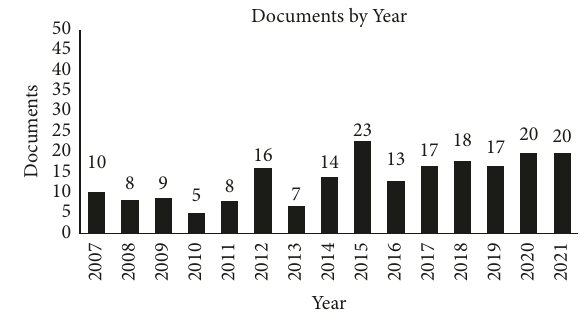
Figure 2: Publication by